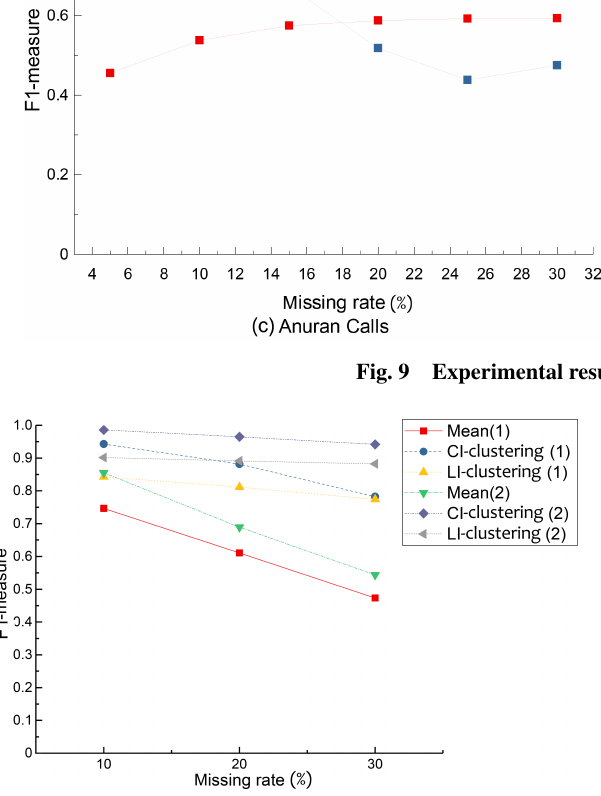
Fig. 10 Experimental results of